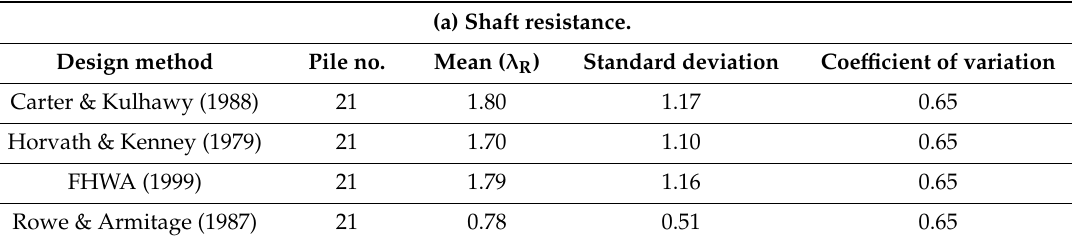
Table 9. Statistical characteristics of shaft resistance (a) Shaft